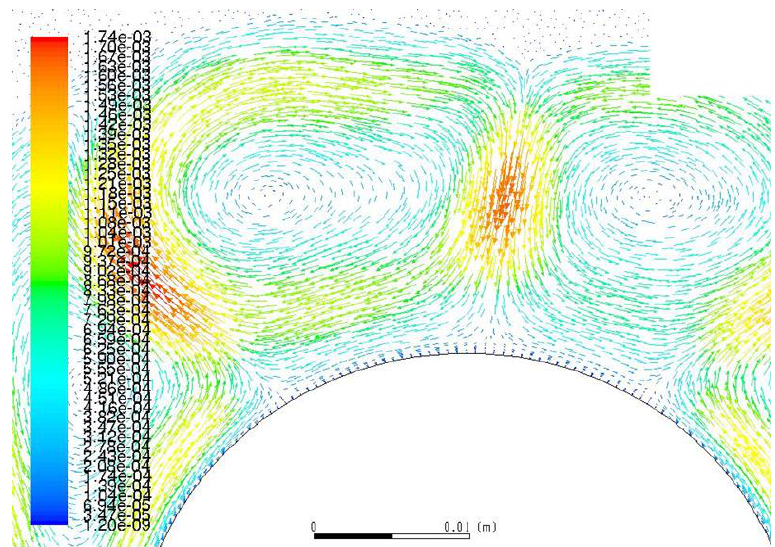
Figure 14. Magnification of Figure 16—formation of molten material vortices.